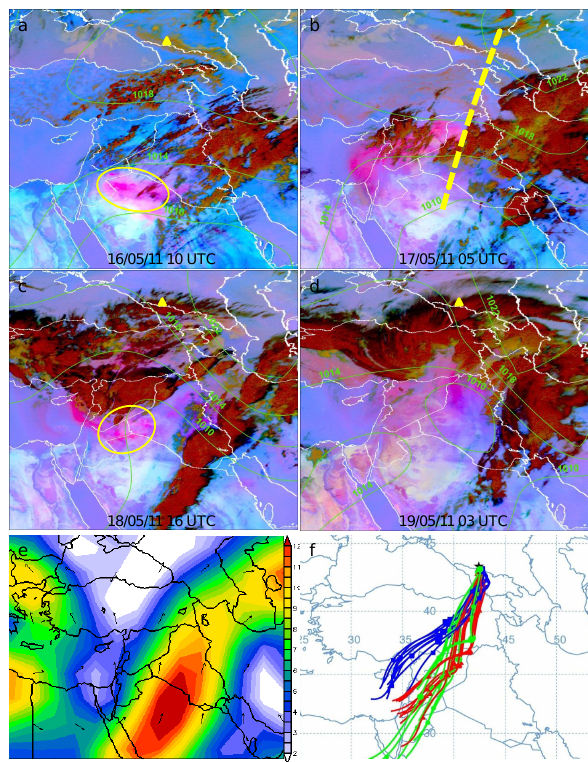
Fig. 6. (a–d) SEVIRI-derived RGB false colour composite images for 16–19 May 2011. The colour scheme, isobars and signs are as on Fig. 5. (e) Four-day (16–19 May 2009) average wind speed (ms − 1 ) and direction at 700hPa. (f) Two-day three-dimensional back tra- jectories from HYSPLIT model starting at 43.348 ◦ N; 42.427 ◦ E; 5000ma.s.l. at 03:00UTC on 19 May 2011. CALIOP/CALIPSO lidar transact for 17 May 2011 is shown as yellow dashed line (see Fig. 7b).